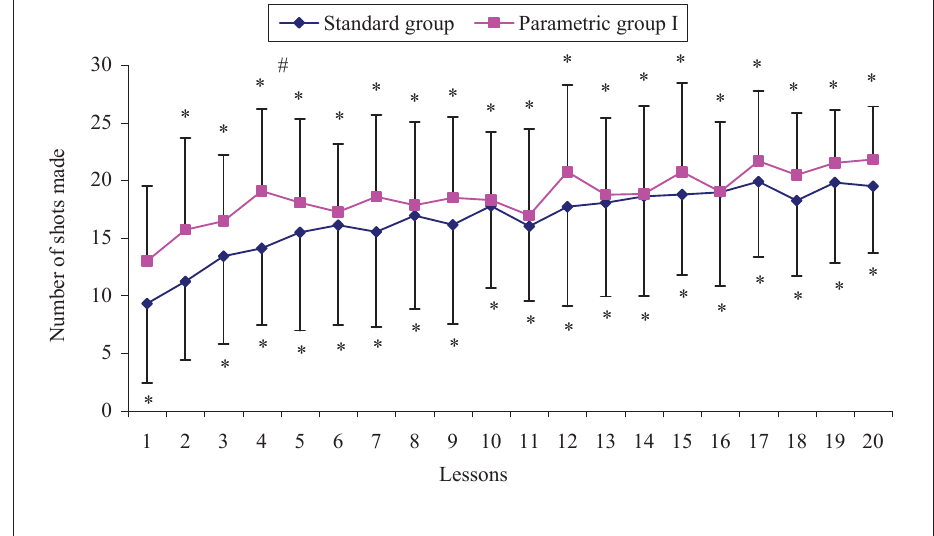
Fig. 5. The indices of the development of mastering movements performing a set shot in the standard group and the second group of parametric teaching